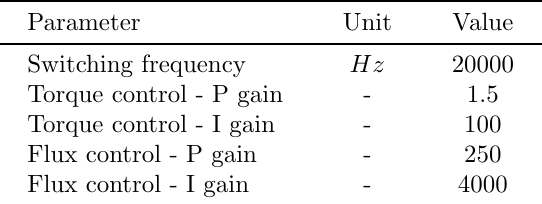
Table 8: DTC-SVM specific parameters